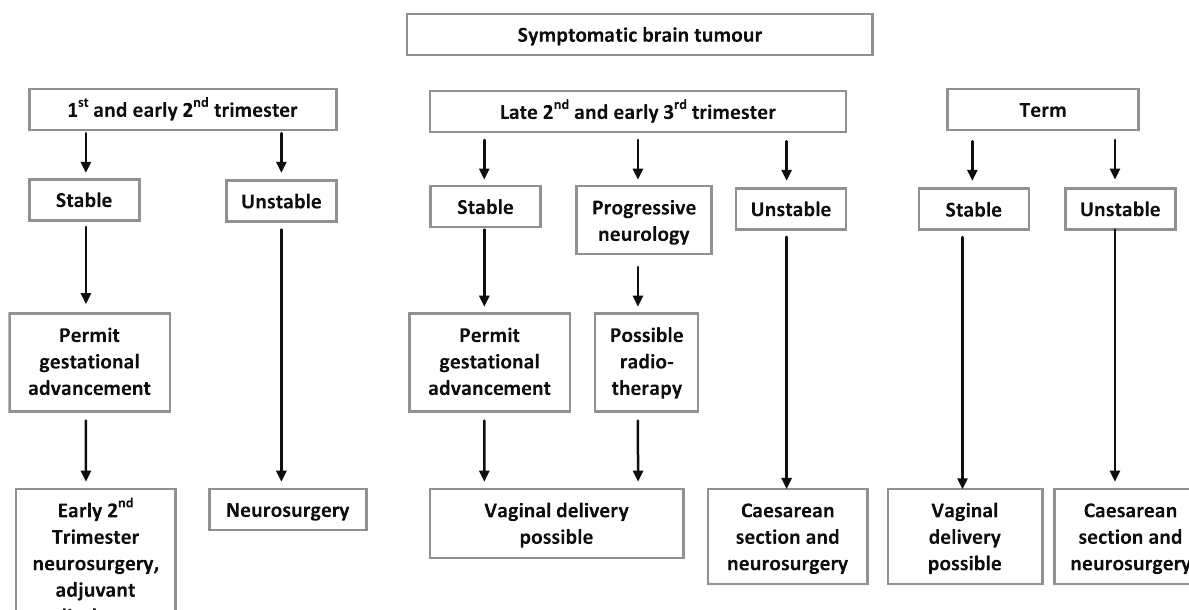
Figure 1. Algorithm for management of brain tumours in pregnant